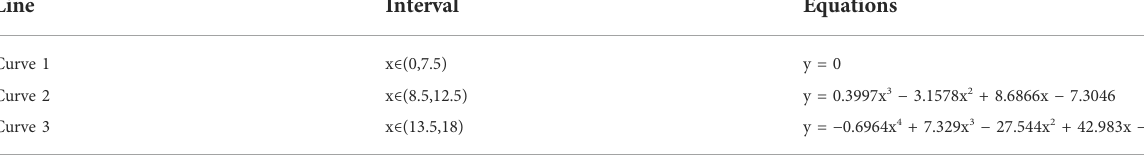
TABLE 1 The equations of the curves. Line Interval Equations